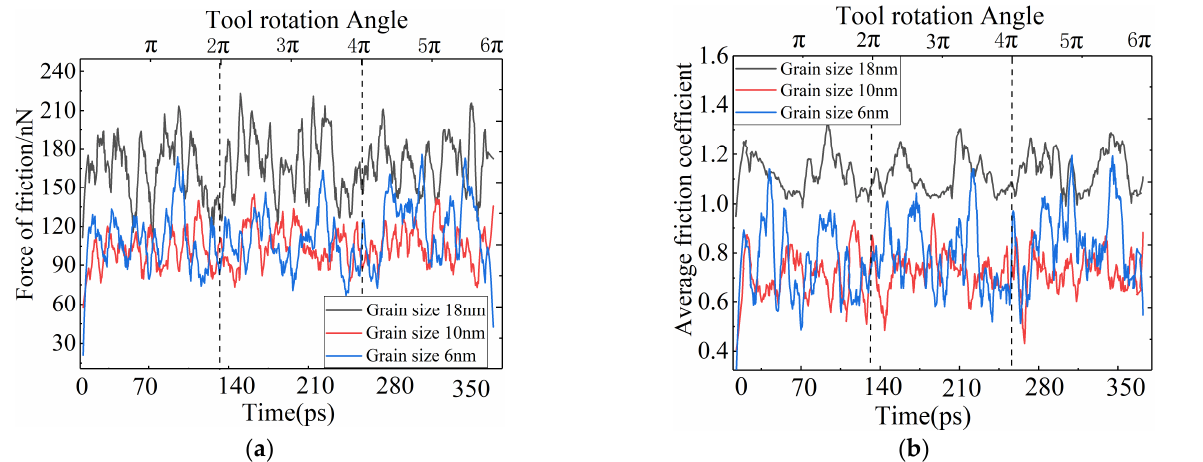
Figure 16. Frictional force and friction coefficient with different grain sizes, ( a ) is the frictional force diagram and ( b ) is the friction coefficient diagram.